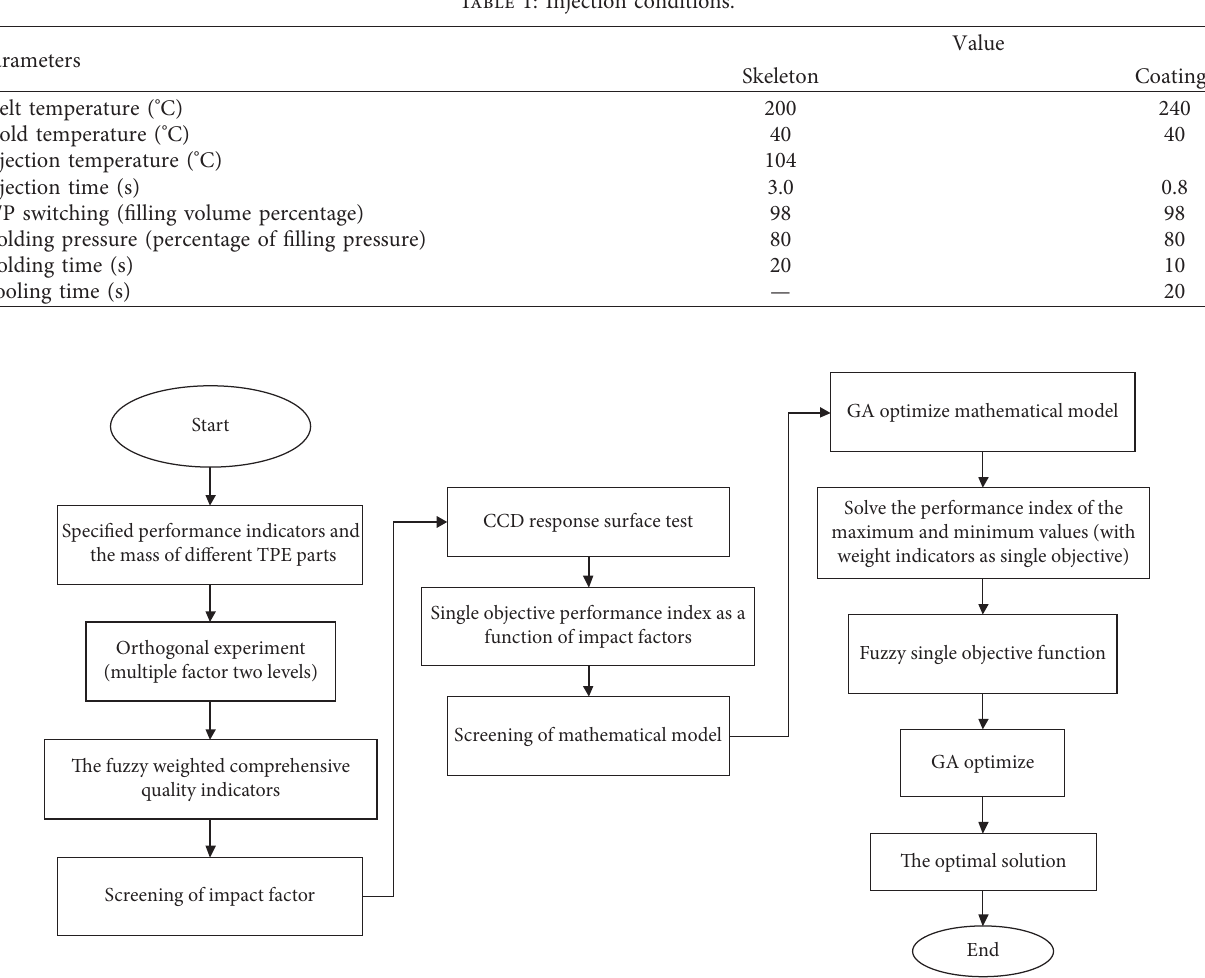
Figure 1: Solving process of the optimization method [19].